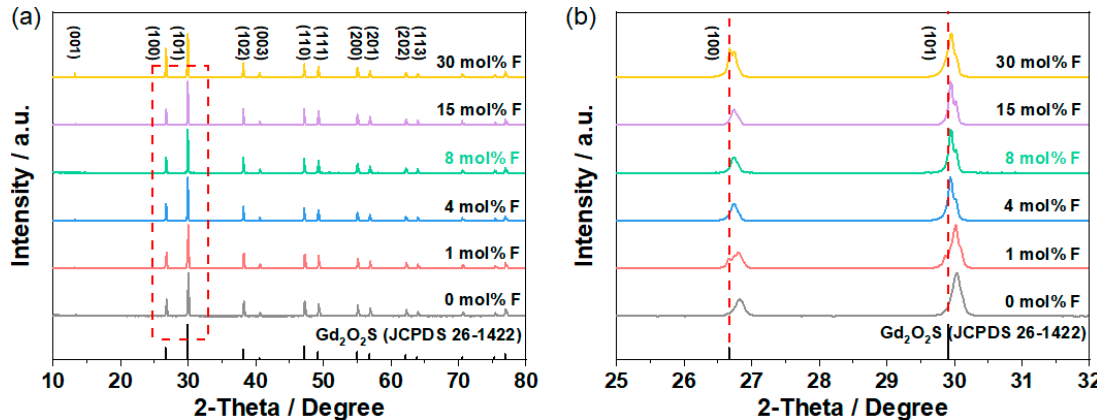
Figure 1. ( a ) XRD profiles and ( b ) local magnified view of the GOS:Tb, x F scintillators. The shape and size of scintillator particles influence their luminescence